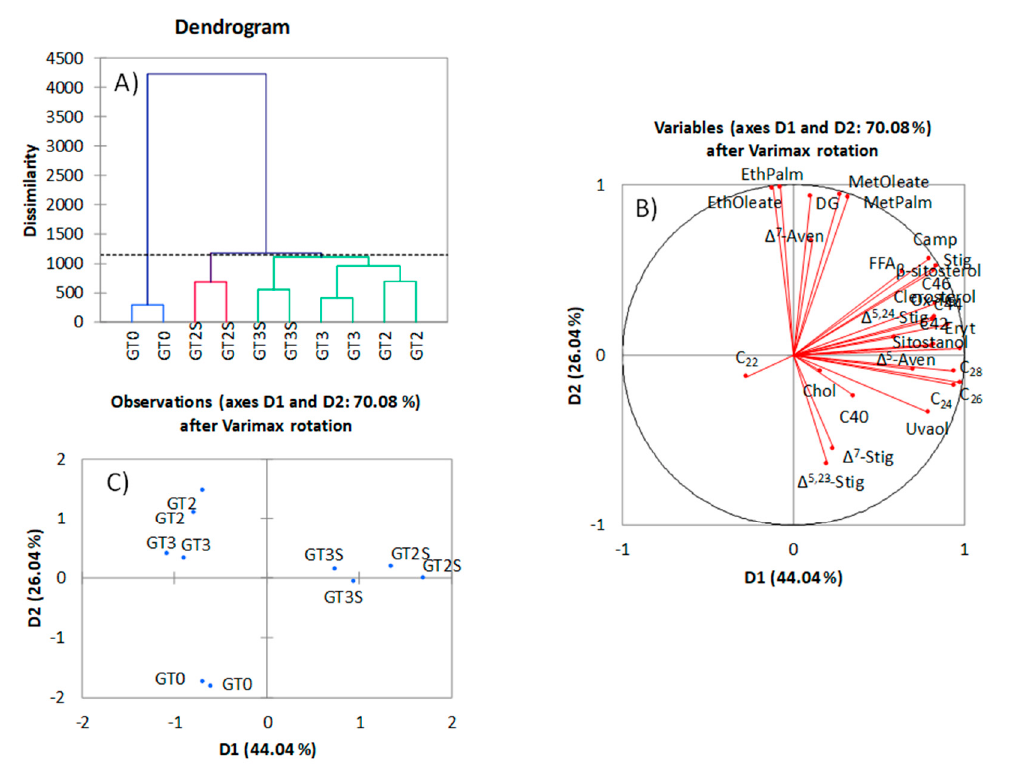
Figure 1. Cluster ( A ) and Principal Component Analysis (PCA) ( B , C ), based on the original dataset of the overall minor components in green Spanish-style Gordal table olive fat: GT0, GT2 and GT3 are oils extracted from the fresh, fermented and packaged olives, respectively. Samples coded S were extracted by Soxhlet; otherwise, they were extracted by Abencor. See Table 1 for other abbreviations.